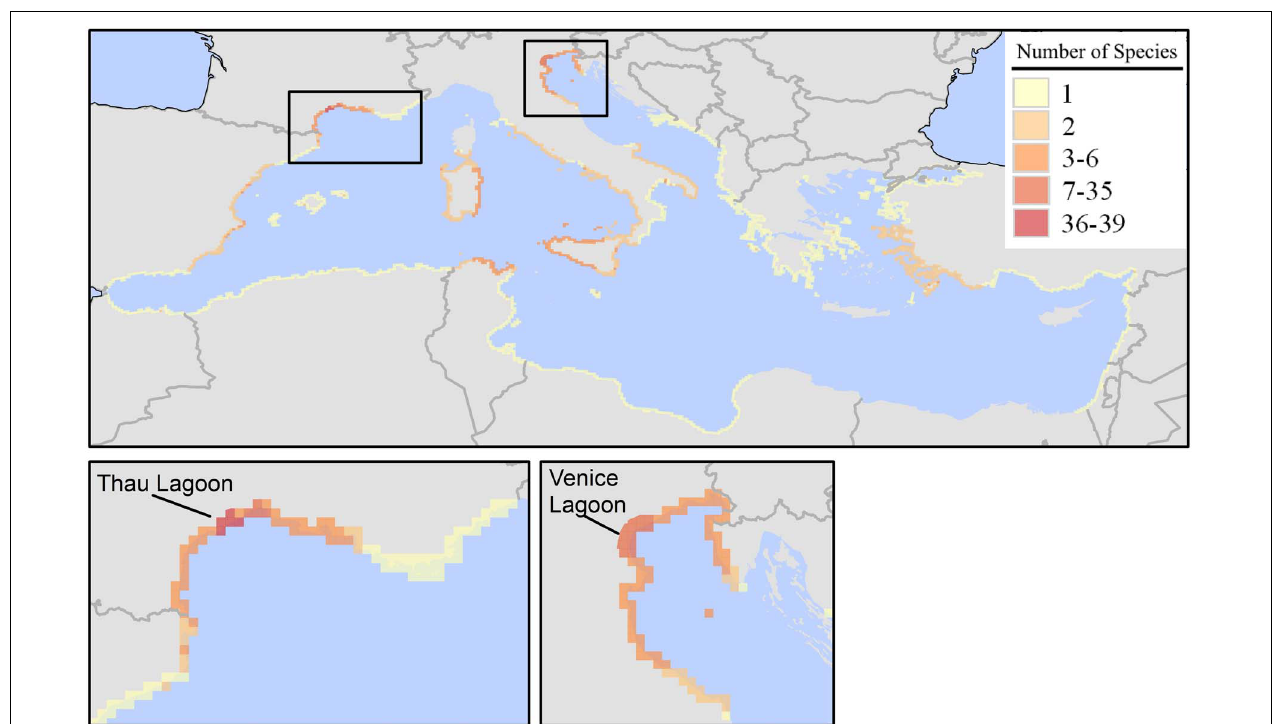
FIGURE 4 | Richness (number of species in a 10 × 10 km grid) of marine alien species introduced in the Mediterranean Sea by aquaculture (either as commodities or contaminants). Map was produced by EASIN’s mapping